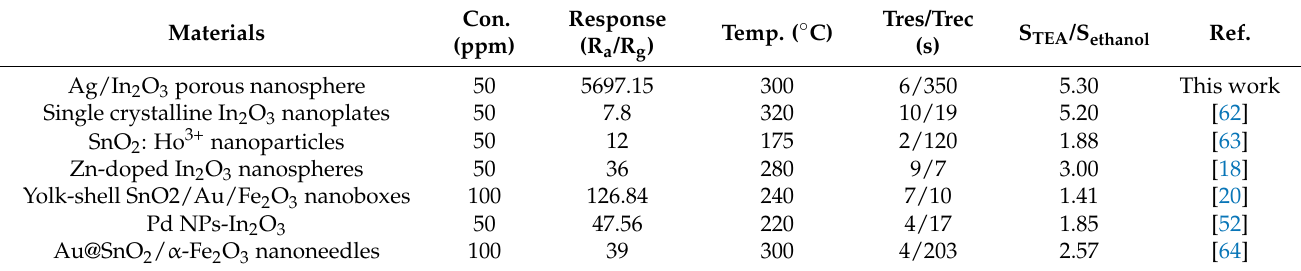
Table 1. Compared TEA sensing performances of different